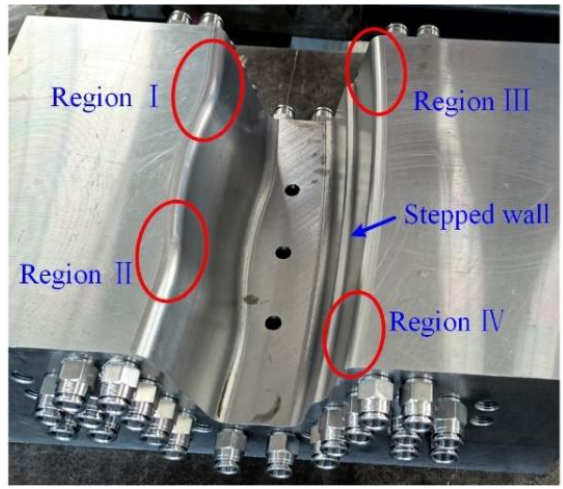
Figure 6. The photos of die surfaces.